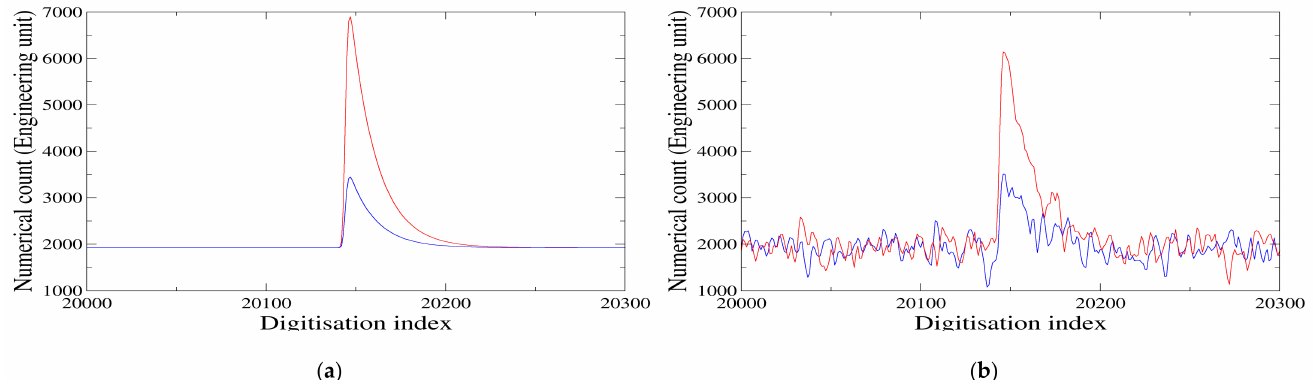
Figure 15. Example of signals. ( a ) without noise. ( b ) with noise. The On (blue) and Off (red) signals correspond to the same digitisation index because the sampling index of each is counted from its own emission time. The vertical distribution of the ground reflectance is symmetrical with respect to its mean value. The asymmetry of the signals over time is only due to the shape of the response function (see Appendix